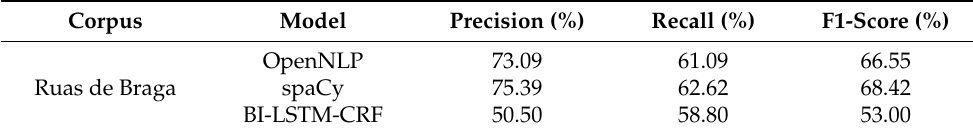
Table 4. Generalized NER model validation results on Ruas de Braga